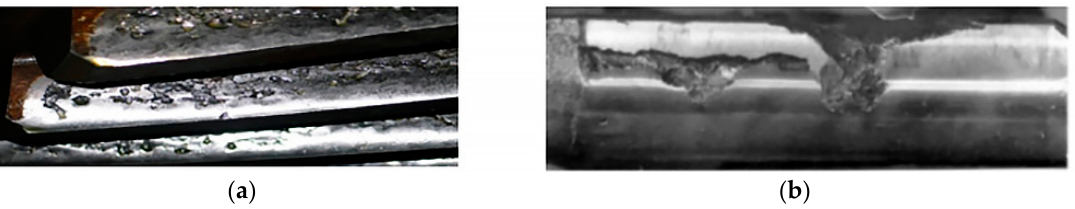
Figure 1. Contact tooth surface fatigue: ( a ) surface (pitting); ( b ) surface and deep, turning into a cleavage.